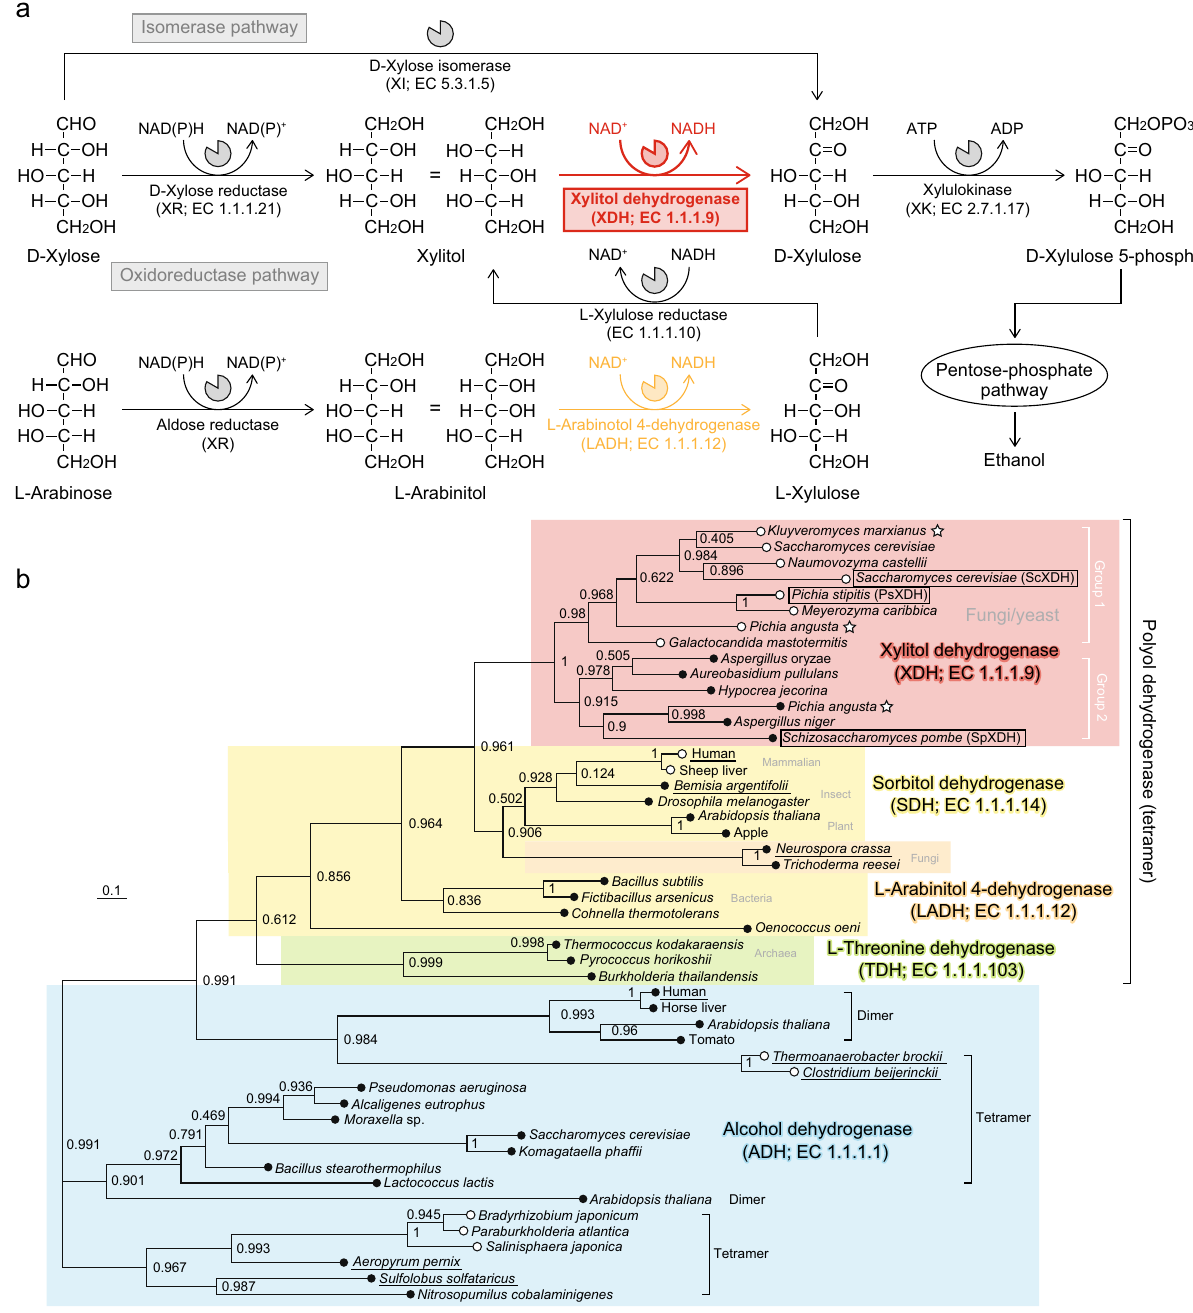
Figure 1. d-Xylose metabolism by yeast and fungi. ( a ) Metabolic network of d-xylose and l-arabinose. There are two routes of d-xylose metabolism, with XDH being involved in the oxidoreductase pathway. This pathway partially overlaps with l-arabinose metabolism, in which LADH belongs to the same protein family as XDH, described in ( b ). ( b ) A phylogenetic tree of the zinc-dependent MDR superfamily group. The number on each branch indicates the bootstrap value. Subfamilies of XDH, SDH, LADH, TDH, and ADH are colored in red, yellow, orange, yellow-green, and cyan, respectively. Open and closed circles at the end of each branch are enzymes in the absence and presence of structural zinc, respectively. XDHs with asterisks were enzymes from thermotolerant yeast. Proteins in the box were purified and characterized in the present study. Underlined proteins were used for discussions in the